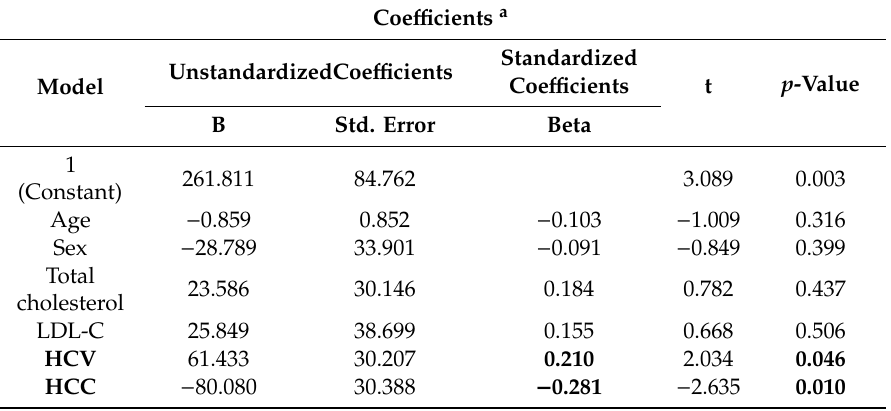
Table 2. Multivariate analysis of whole population.